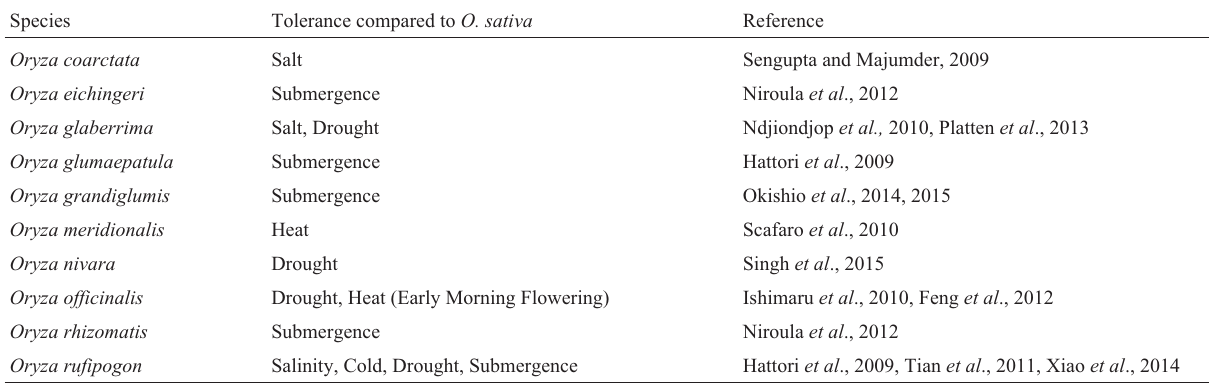
Table 2 - Tolerance to abiotic stresses found in accessions of Oryza species and references. Tolerance compared to O.